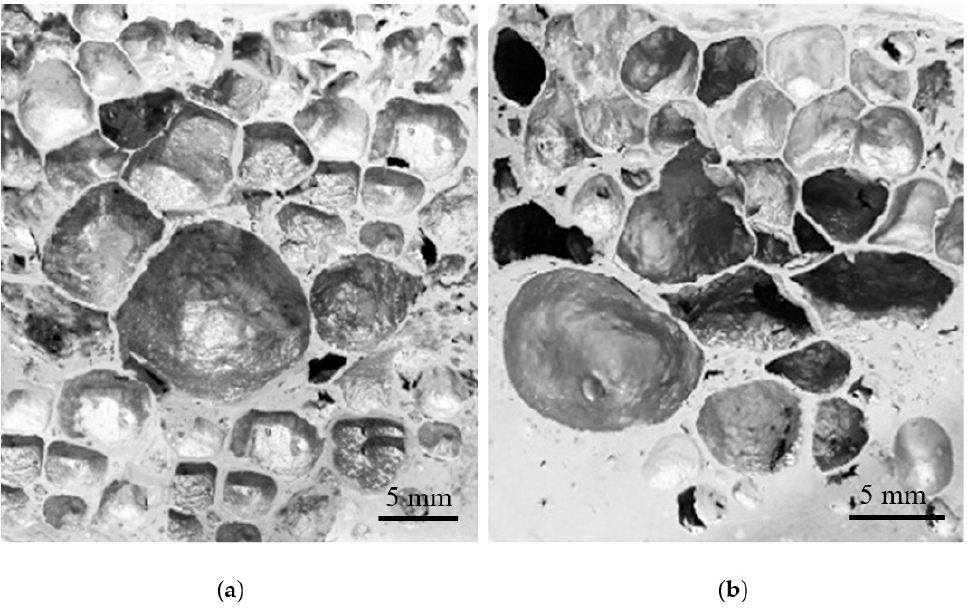
Figure 7. Macrostructures of Al–10Ni foams with 7 wt.% ( a ) and 10 wt.% ( b ) dolomite additions.